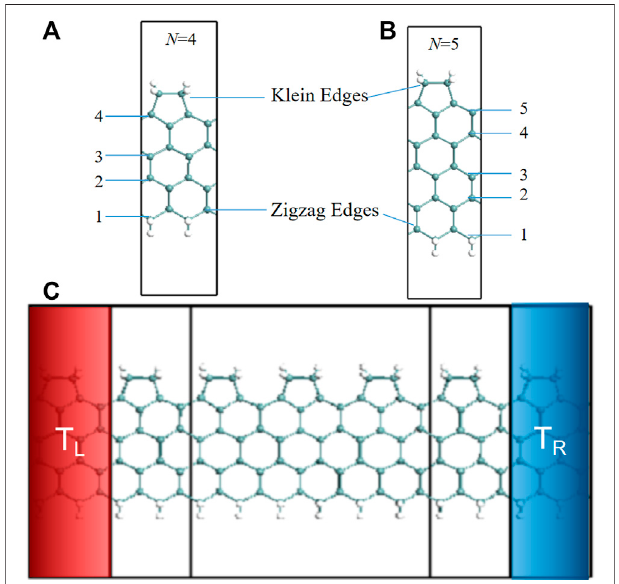
FIGURE 1 | (A) , (B) Optimal structure of the N-ZKGeNRs (say N = 4, 5), in which Ge and hydrogen atoms are described by the dark green and white balls, respectively. (C) Schematic description of the thermal spin device using N-ZKGeNRs (say N =